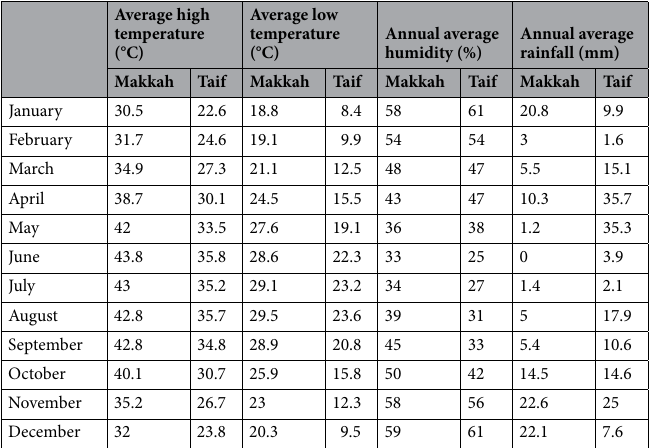
Table 1. Climate data for the two cities between which the study area is